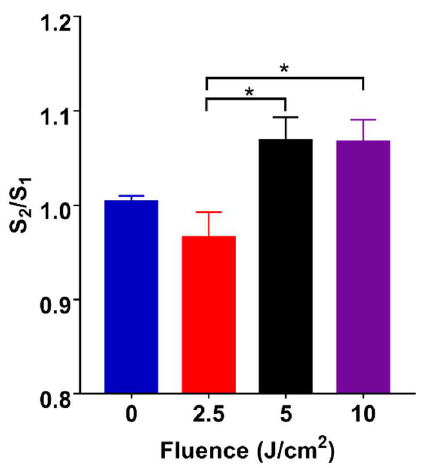
Figure 6. Mitochondrial membrane potential in hADSCs (Passage 10) after 30 min PBM at various